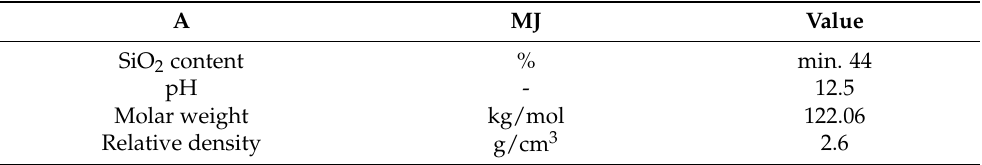
Table 3. Composition of anhydrous disodium metasilicate [34].